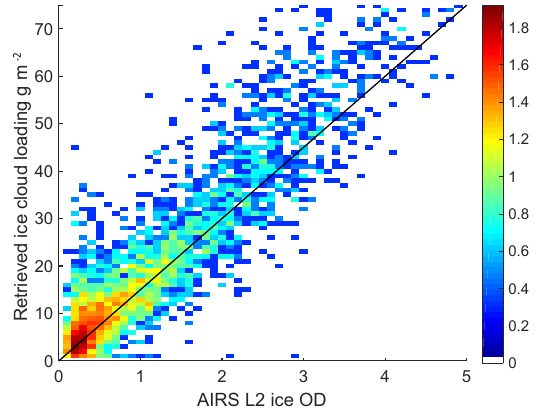
Figure 16. Retrieved ice cloud amount (in gm − 2 ), compared to AIRS L2 ice cloud optical depths. The color bar is the log(10) of the number of points in the